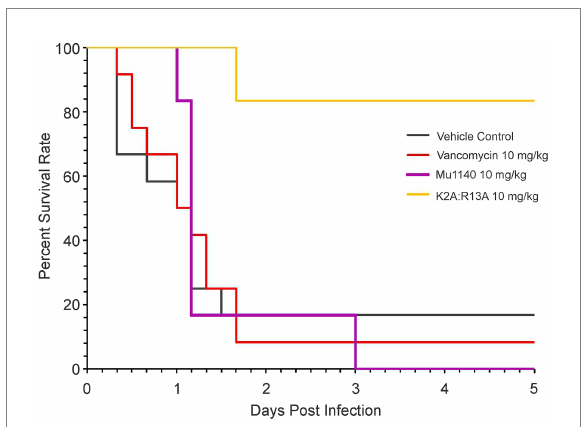
FIGURE 5 Bacteria load on the lesions of mice treated with fusidic acid and mutacins via topical application in a cut-wound MRSA skin infection. All treatments including vehicle control were given to the animals 24 h post-infection and lasted for 6 days. The model contributed to a wide range of variability in CFUs at the site of infection even for the no-drug vehicle control group. The mutacin analog treatment groups, along with fusidic acid group, had 1.34–2.79 logs lower average CFUs compared to the vehicle control group (mean log CFU = 5.33 for the control, 3.16 for fusidic acid, 5.23 for Mu1140 10 mg/kg/day, 3.70 for K2A 10 mg/ kg/day, 2.54 for R13A 10 mg/kg/day, 3.99 for K2A:R13A 5 mg/kg/ day, and 3.08 for K2A:R13A 10 mg/kg/day). No statistical difference was detected among treatment groups ( n = 5 for the vehicle control group, n = 6 for all the other groups, all groups contained equal numbers of male and female mice except for the control group which lost one mouse due to a non- experimental